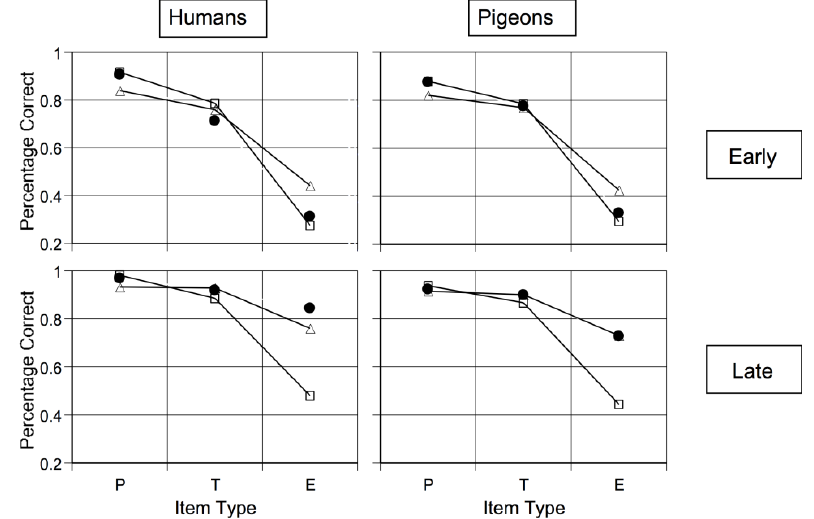
Figure 7. Humans’ and pigeons’ observed and predicted accuracy for prototypes, typical items, and exceptions during the early (top panels) and late ( bottom panels) stages of learning within the prototype-exception task of Cook and Smith [44]. Observed performances are shown as unconnected, filled, black circles. The best-fitting predictions of prototype and exemplar models are shown, respectively, as connected open squares and open triangles. From [44]. Copyright 2006 by the Association for Psychological Science. Reprinted with permission.